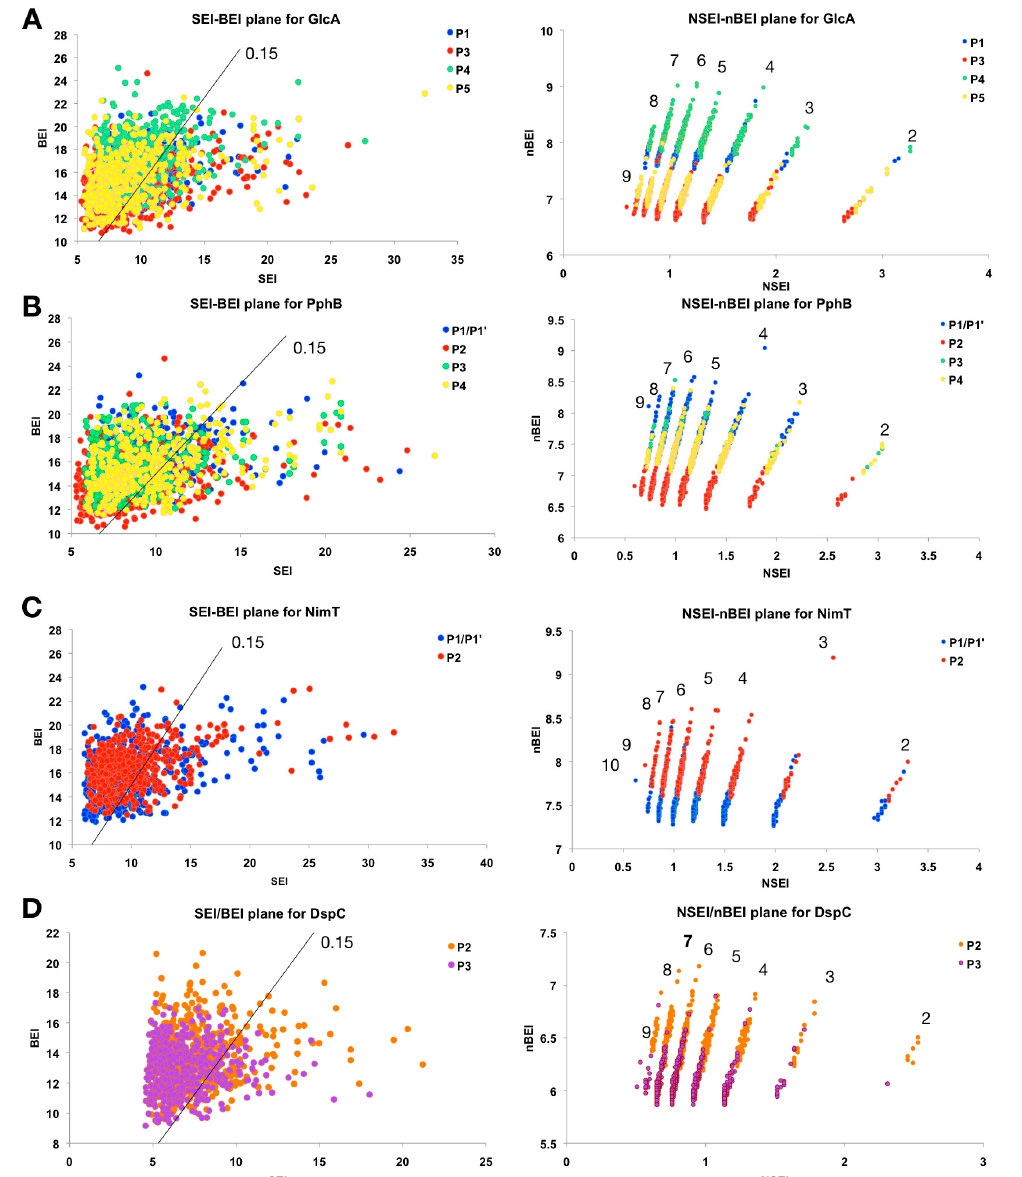
Figure 4. Ligand efficiency plots for binders at the different druggable pockets in AfPPases. On the left, the ligand efficiency plots for clusters obtained from targeted docking. The top 500 compounds (ranked by ∆ G) from each cluster are shown. Dots are coloured according to pocket binding for each cluster, as indicated in the plot legend. Line indicates the polar surface area (PSA)/molecular weight (MW) ratio of 0.15 (values defined from the mean PSA and MW of marketed drugs, ([23]). To the right of the line, compounds occupy a favourable chemical space, were binding efficiency index BEI and the surface-binding efficiency index SEI are maximised close to the diagonal of the SEI/BEI plane. On the right column, the NSEI–nBEI plots are shown. Selected ligands (top 500 ranked by ∆ G) are displayed; dots are coloured according to the pocket they bind to as indicated in the plot legend. Each diagonal line of ligands represents a specific NPOL (number of N and O atoms in the compound) as indicated by the number above each line. Plots are shown for GlcA ( A ), PphB ( B ), NimT ( C ), and DspC ( D